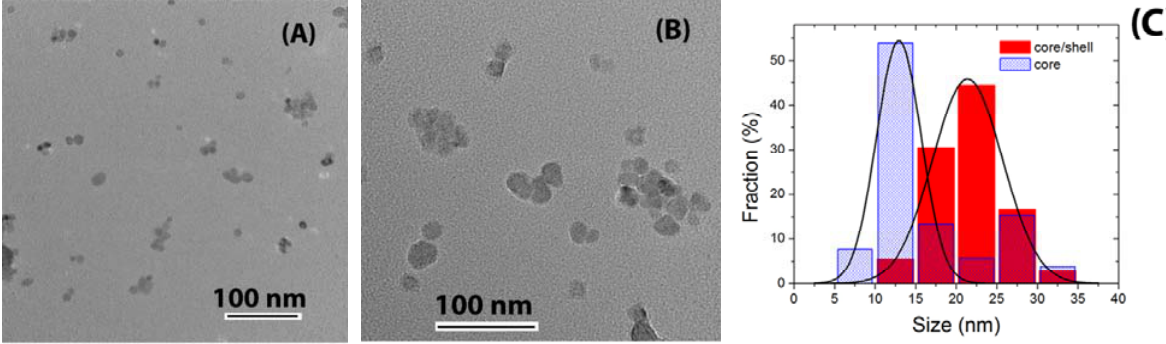
Figure 5. TEM images of (A) core and (B) core/shell CaF corresponding nanoparticle size histogram.